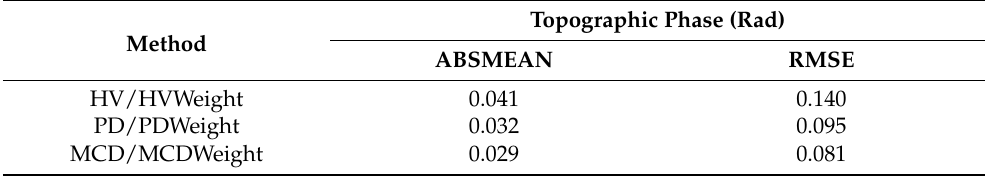
Table 2. Estimation results of the topographic phase.